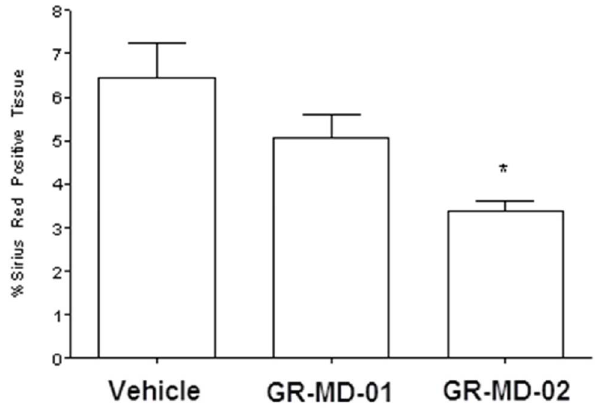
Figure 3. Graphical representation of the percentage Sirius red positive tissue from experiment described in Figure 1. Statistical analysis performed was One Way ANOVA with a Bonferroni’s post-test comparing the three groups. *=p , 0.05 compared to Vehicle Group.